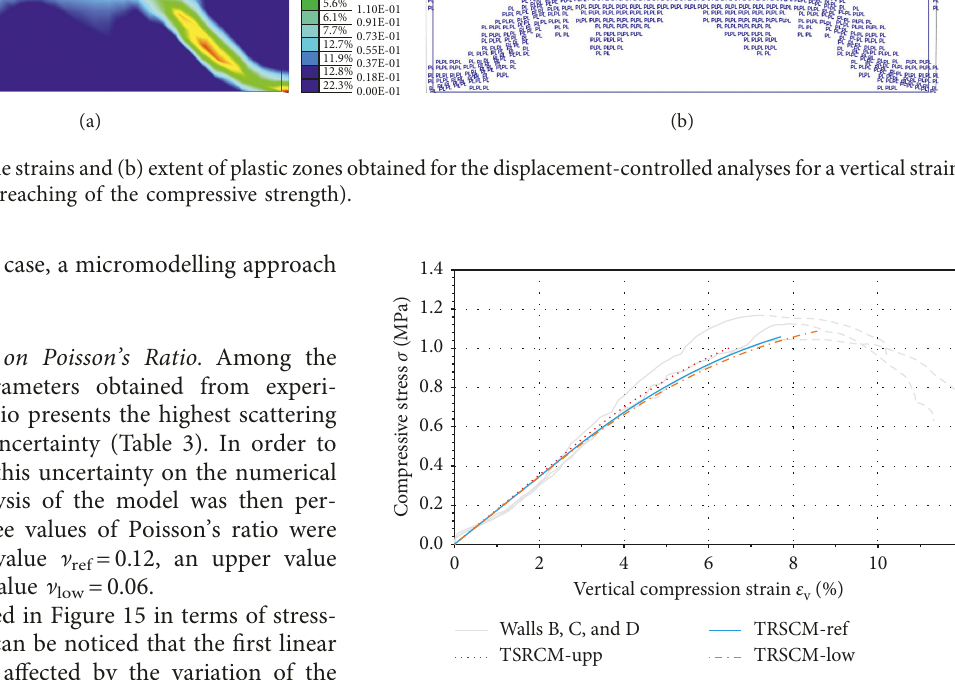
Figure 15: Influence of Poisson’s ratio on the numerical